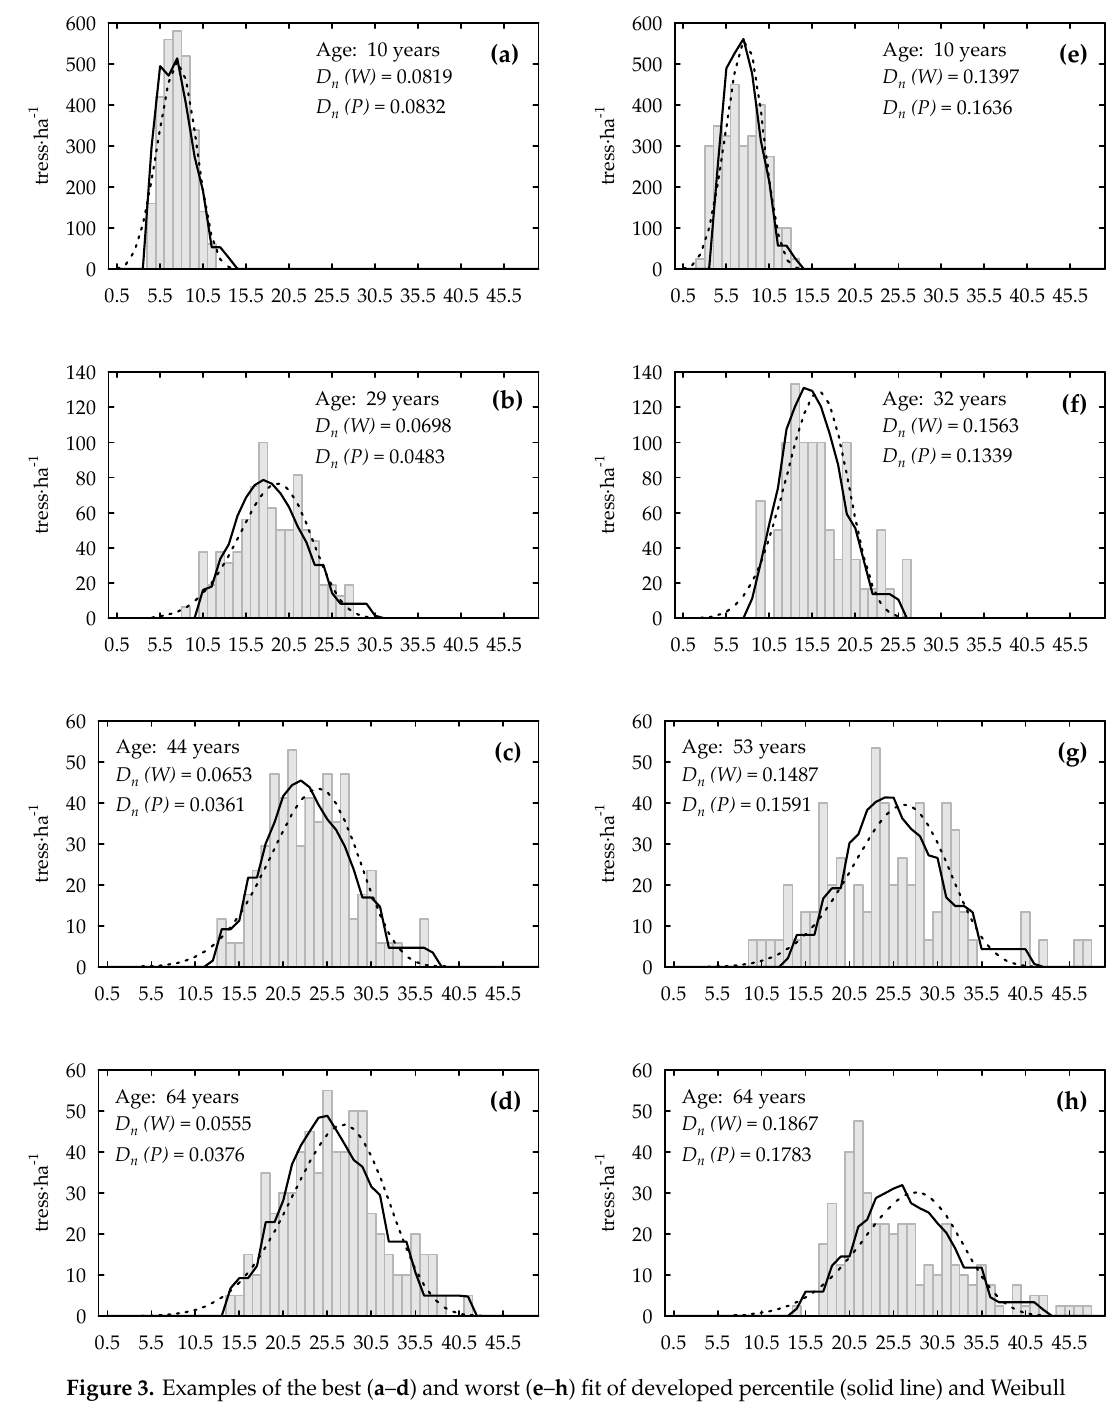
Figure 3. Examples of the best ( a , b , c , d ) and worst ( e , f , g , h ) fit of developed percentile (solid line) and Weibull (dotted line) models for test data in subsequent age classes (from top to bottom). D n (W) and D n (P) are the Kolmogorov – Smirnov statistics for Weibull and percentile models, respectively. The mean Kolmogorov – Smirnov statistic D n was 0.0786 and 0.0919 for the overall set of studied stands, for the percentile and Weibull models, respectively (Table 3). The Wilcoxon signed-rank test revealed that the two models differed significantly in terms of that criterion ( Z = 7.097; p < 0.05; Table 4). In both models, the highest D n statistic was found for stands in the first age class (Table 3),